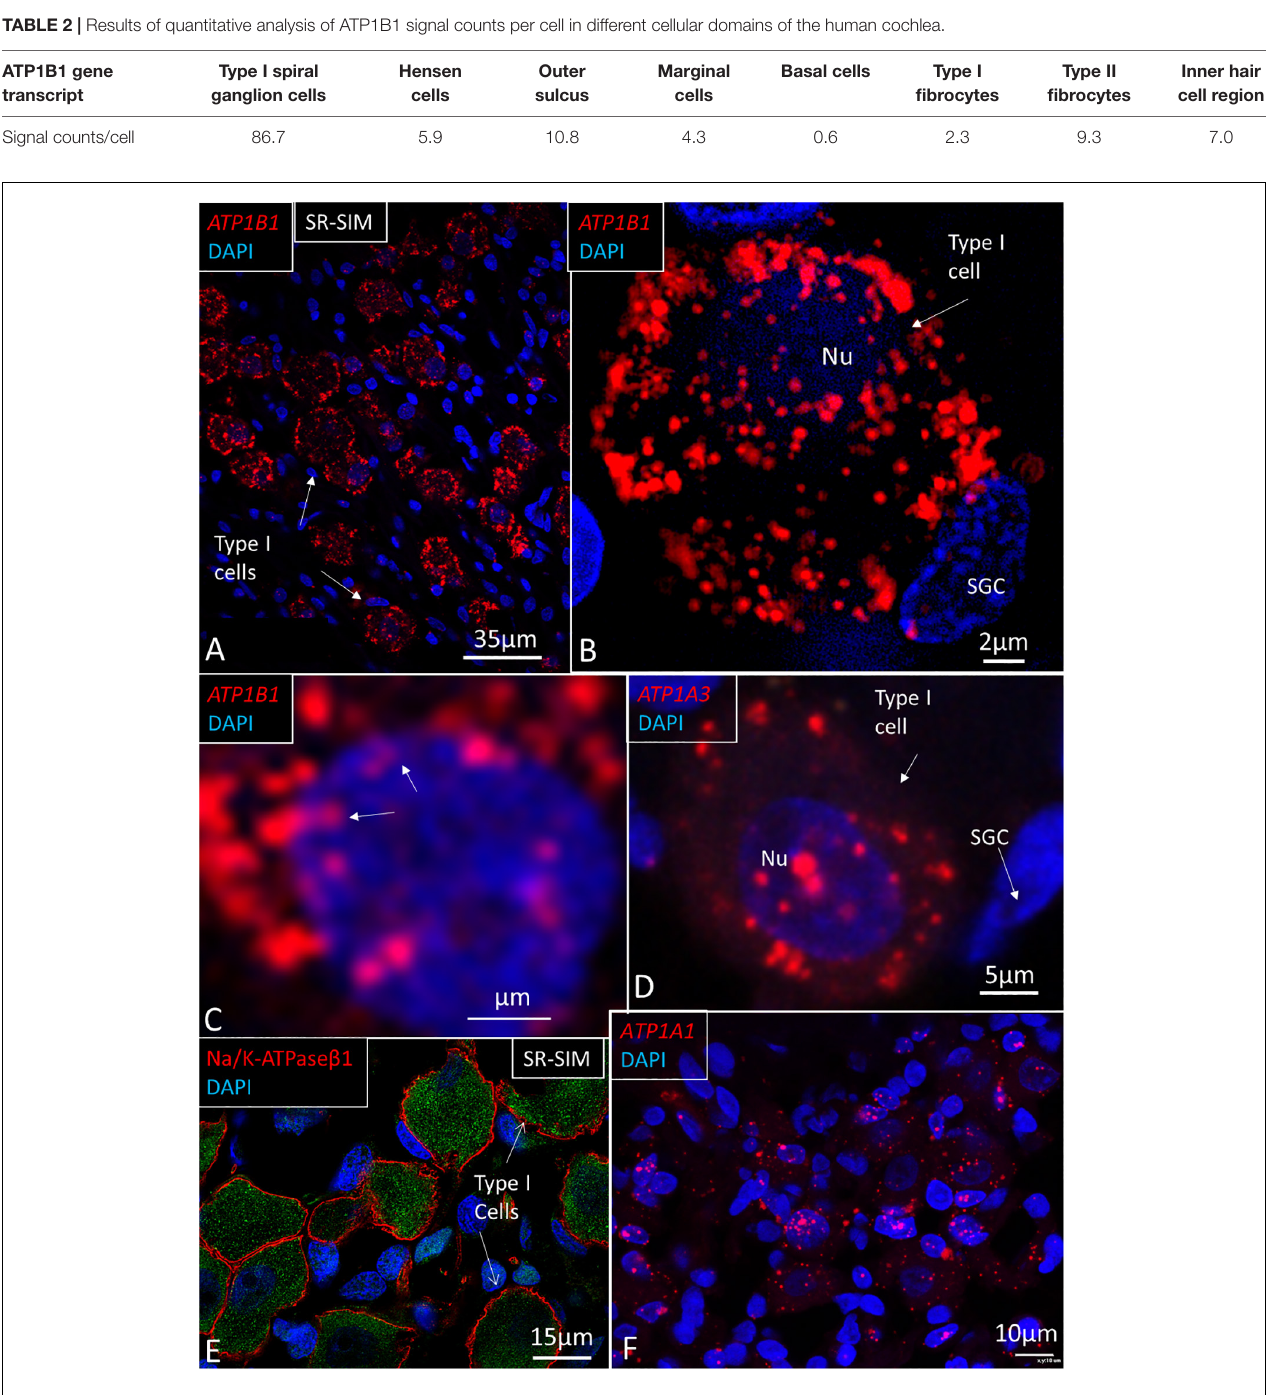
FIGURE 10 | SR-SIM of human spiral ganglion. (A) Type I spiral ganglion cells display a large number of red ATP1B1 gene puncta. (B) Higher magnification of a type I cell shows gene transcripts in the cell nucleus (Nu) and cytoplasm. (C) ATP1B1 gene transcripts are seen at the periphery of the cell nucleus, assumingly at the nuclear pores (arrows). (D) ATP1A3 transcripts in a type I spiral ganglion cell. (E) SR-SIM of type I ganglion cells shows NKA β 1 expression along the plasma lemma. (F) ATP1A1 gene expression in Rosenthal’s canal. Both ganglion cells and adjacent cells show the expression of ATP1A1 . SGC, satellite glia cell.